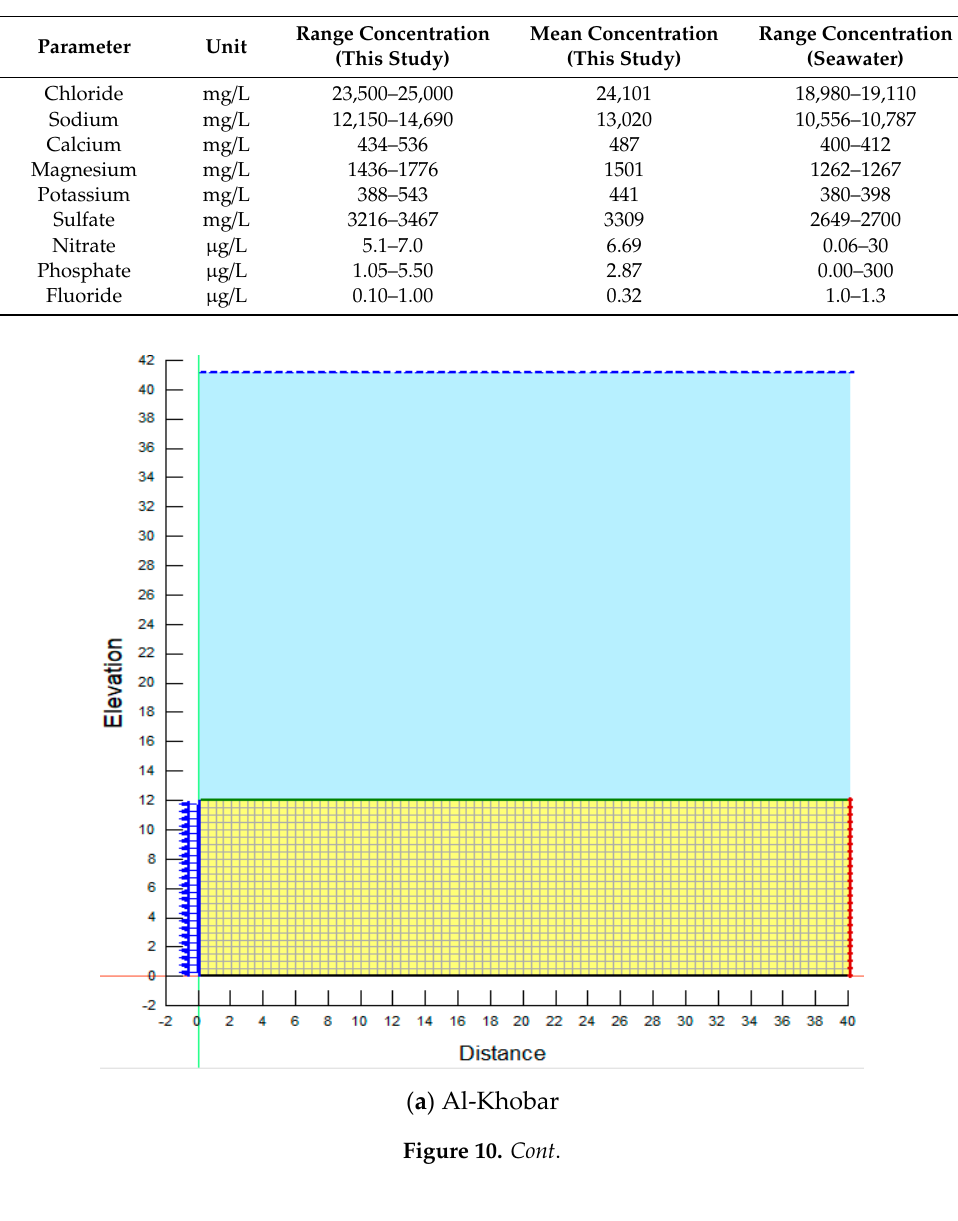
Table 6. Concentration of major elements and ions for intake gulf water. Table 7. Model Parameters.